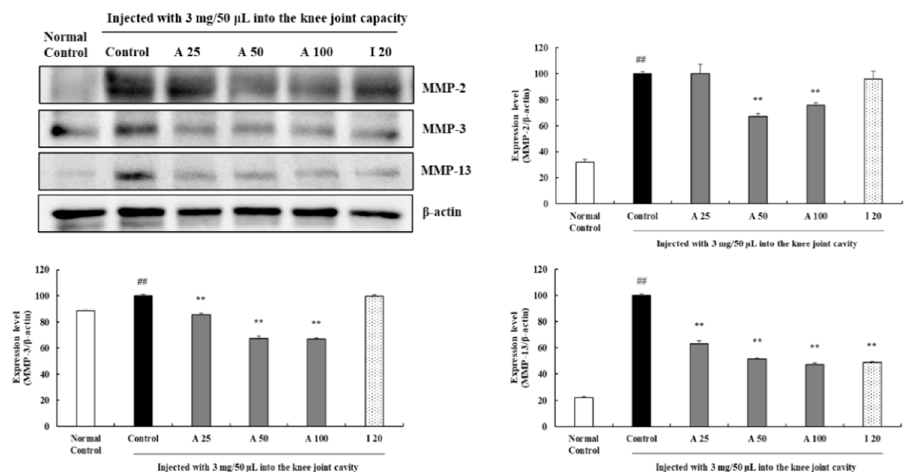
Figure 9. AyuFlex ® decreased the production of MMP-2, -3, and -13 in arthrodial cartilage. The expression of MMP-2 (62, 72 kDa), MMP-3 (54 kDa), and MMP-13 (54 kDa) was determined by western blotting. Protein bands were quantified using ImageJ. As the control for normalization, β -actin was utilized. The results are expressed as the mean ± SEM of independent experiments ( n = 3 / group). A, AyuFlex ® ; I, Ibuprofen. ** p < 0.01, in comparison with the MIA-induced control group; ## p < 0.01, in comparison with the non-MIA induced control group.